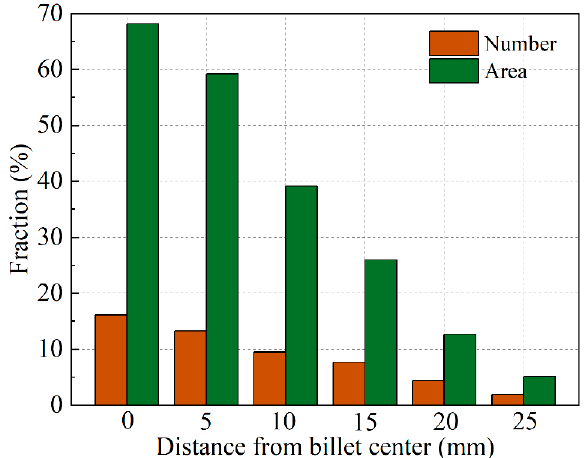
Figure 6. Experimental distribution of the floating grains in the central region of the DC-cast billet.